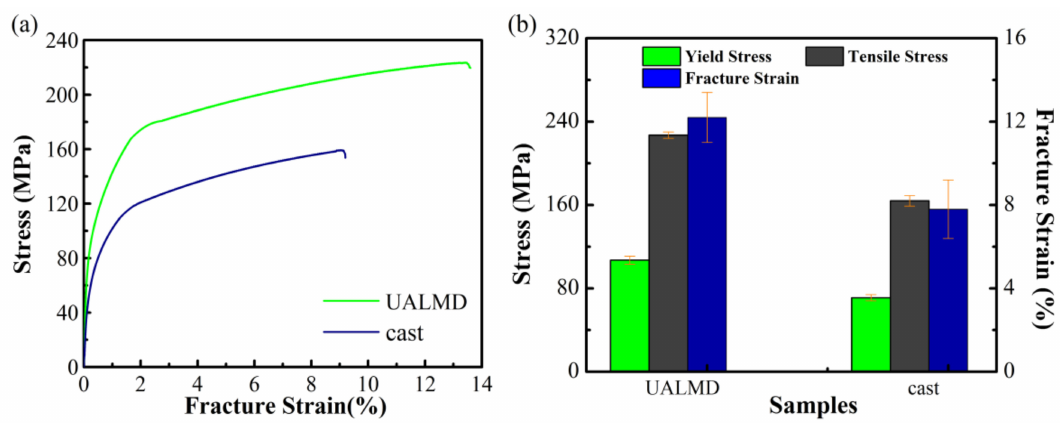
Figure 8. Tensile test results of Al 4047 alloys prepared by casting and UALMD process: ( a ) stress-strain curve; and ( b ) tensile characteristic histograms.